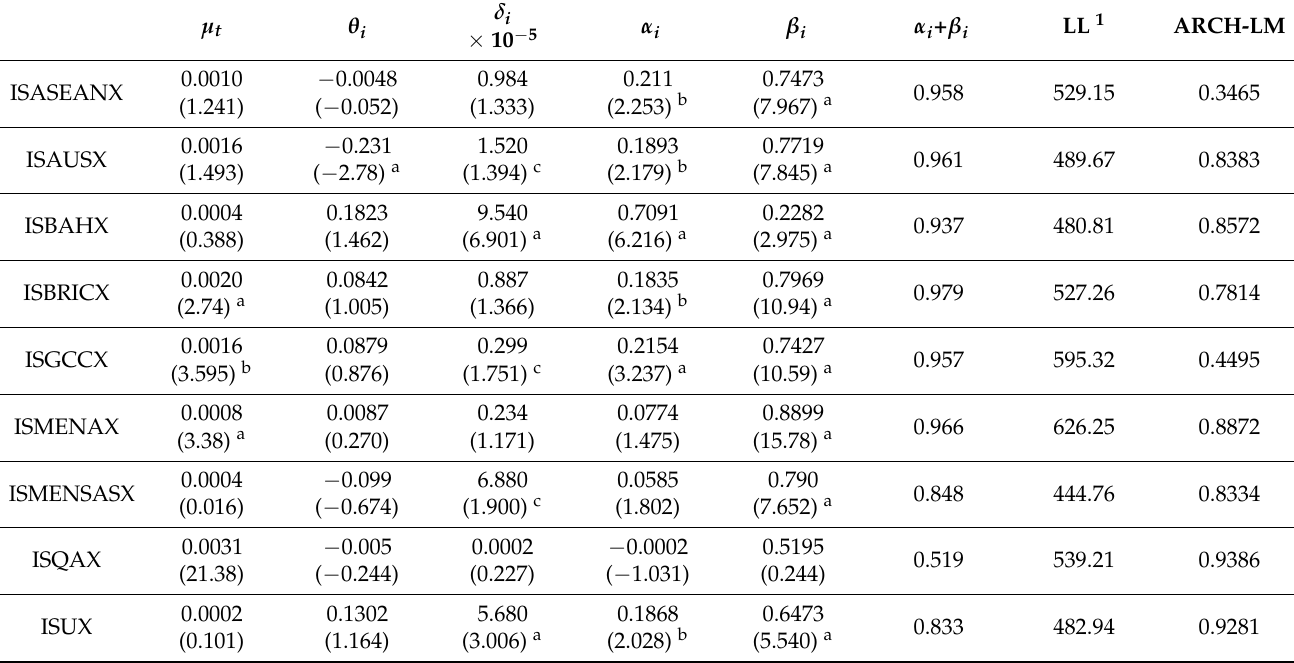
Table 9. GARCH (1, 1) post-crisis